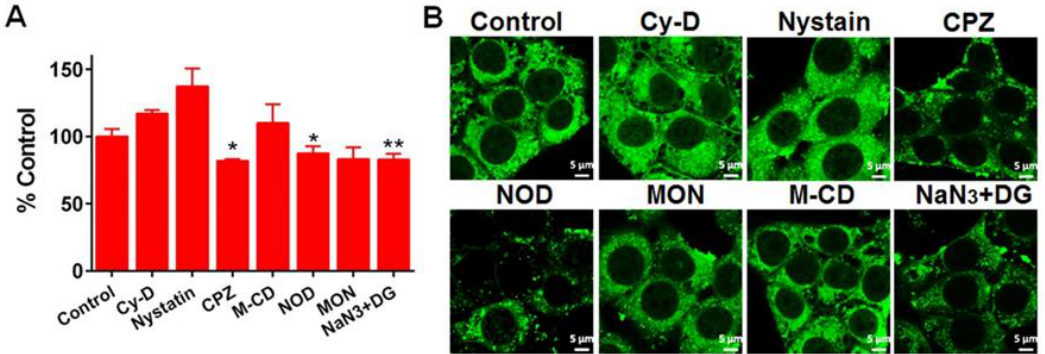
Figure 6. Endocytosis mechanism of FITC–ANSs in A549 cells. ( A ) Quantification uptake pretreated with cellular uptake inhibitors by flow cytometry ( n = 5, * p < 0.05 and ** p < 0.01); ( B ) confocal laser scanning microscope (CLSM) image. The examination was performed after 4 h incubation at an FITC concentration of 2.5 µg/mL.